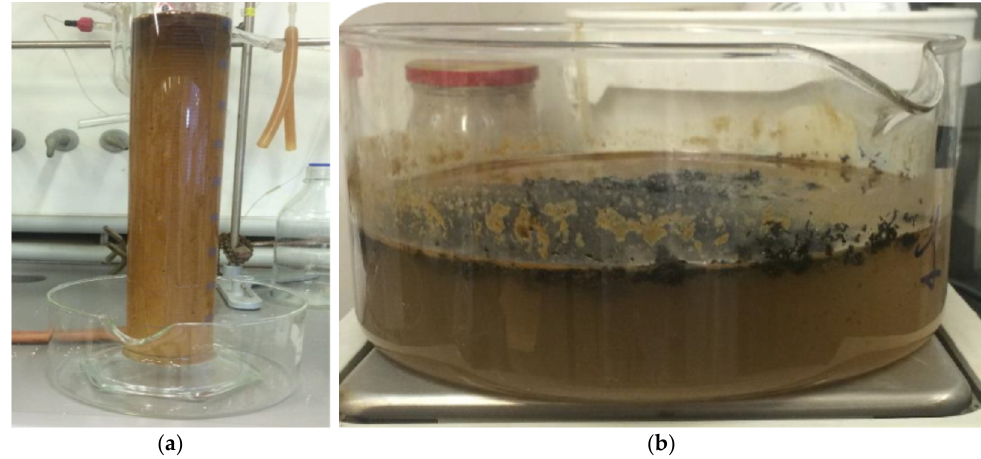
Figure 4. ( a ) Aspect of the real water sample; ( b ) G+ in contact with the real water sample.